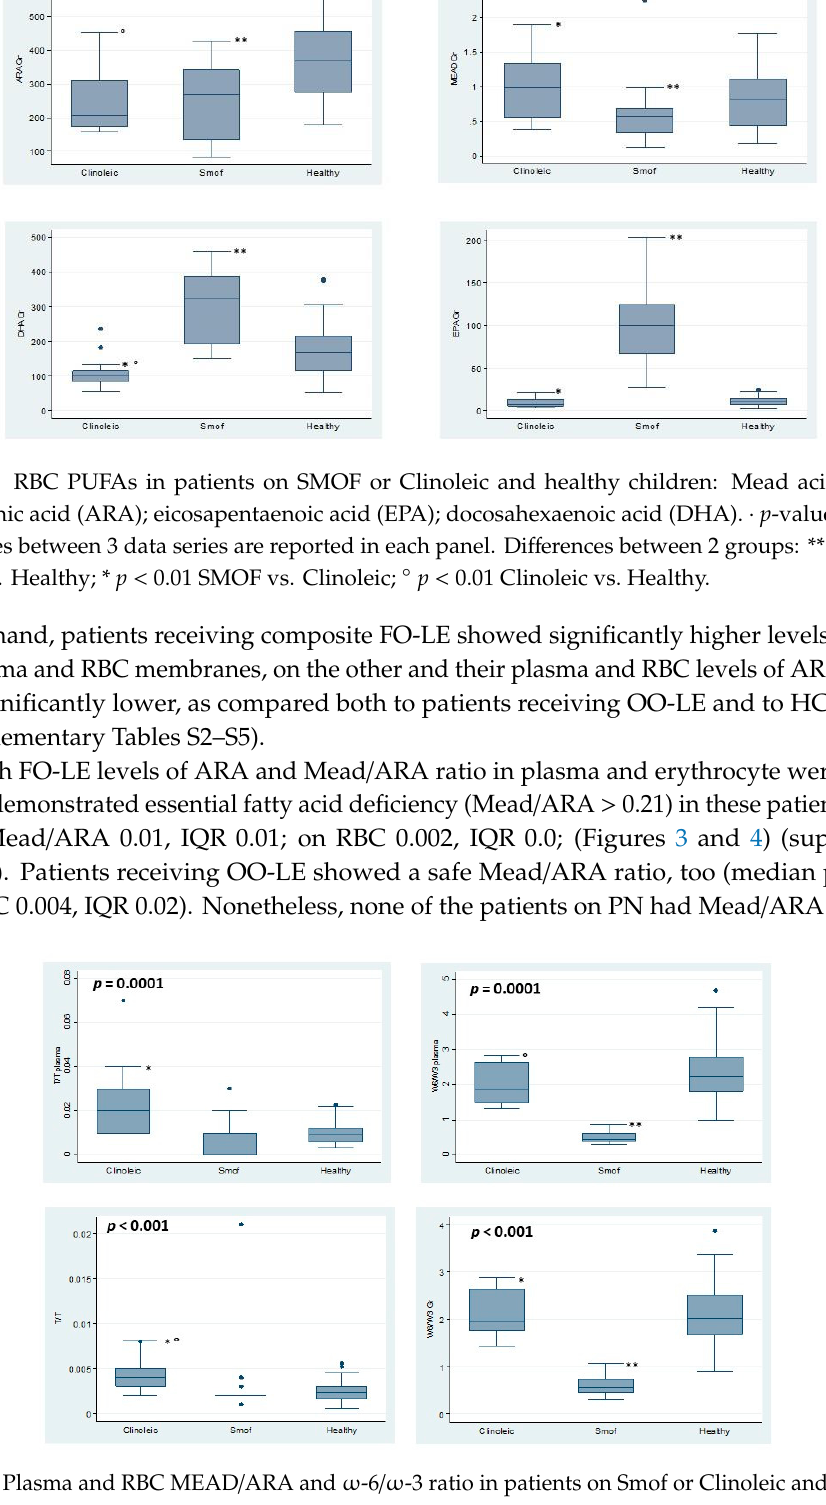
Figure 3. Plasma and RBC MEAD / ARA and ω -6 / ω -3 ratio in patients on Smof or Clinoleic and healthy children. MEAD / ARA (Mead / ARA ratio); ω -6 / ω -3 (omega3 / omeg6 ratio). · p -value for the di ff erences between 3 data series are reported in each panel. Di ff erences between 2 groups: ** p < 0.01 SMOF vs. Healthy; * p < 0.01 SMOF vs. Clinoleic; ◦ p < 0.01 Clinoleic vs